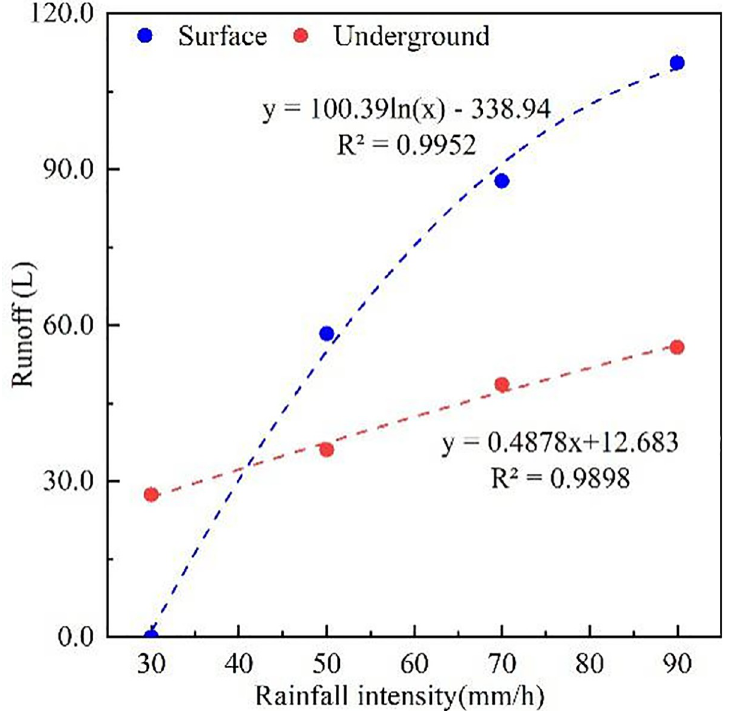
Fig 5. Linear regression equation of rainfall intensity and